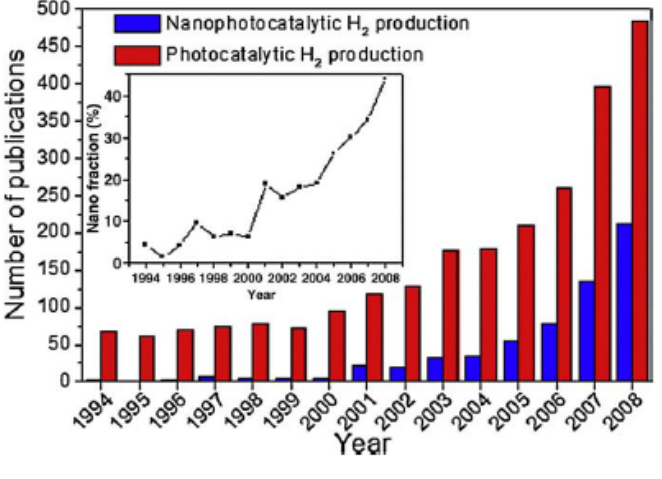
Figure 5. Evolution of the number of publications on (nano)photocatalytic production of hydrogen. Data from Web of Science (ISI,